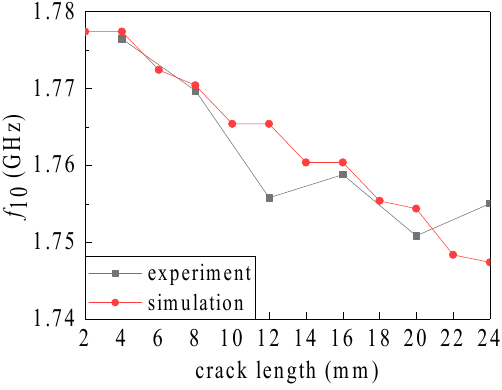
Figure 16. Comparison of simulation and experiment data corresponding to a crack depth of 1 mm.